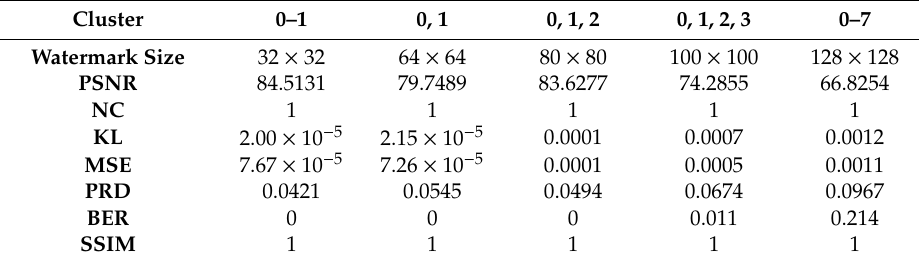
Table 2. Performance of proposed techniques with different watermark sizes and clusters.